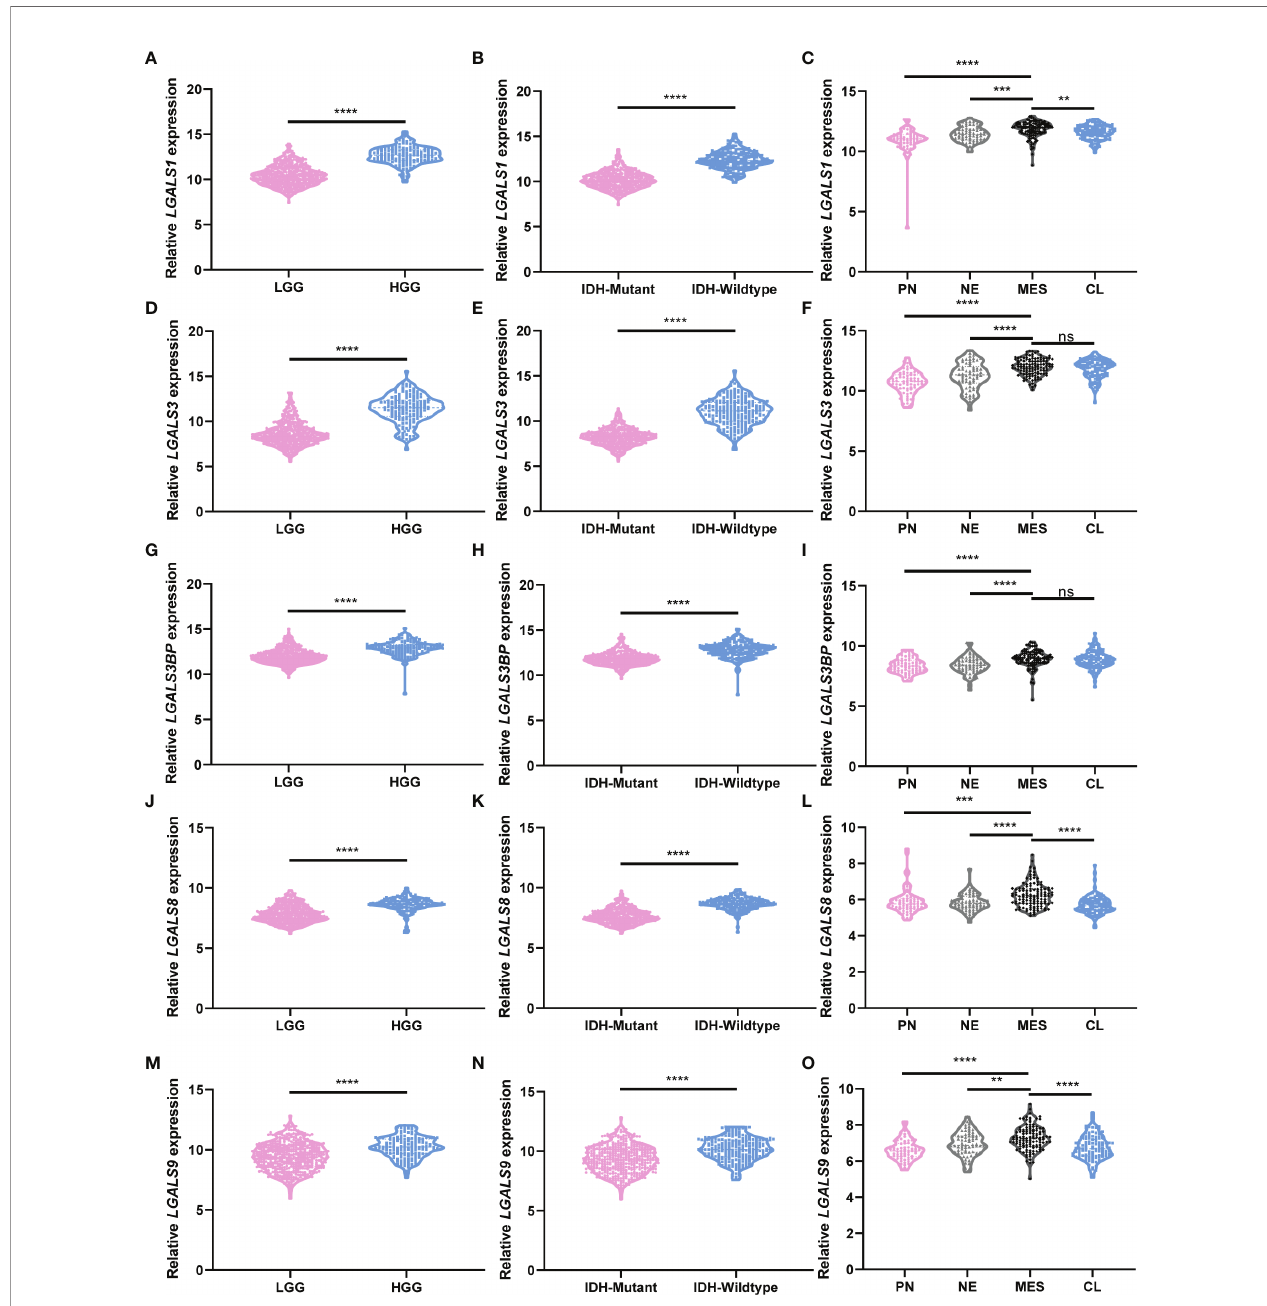
FIGURE 4 | LGALS expression correlates with glioma grades, GBM subtypes, and IDH mutation status in TCGA Glioma dataset. (A) Relative LGALS 1 expression level of LGG and HGG patients in TCGA Glioma dataset. (B) Relative LGALS 1 expression level of IDH-mutant and IDH-wild-type patients in TCGA Glioma dataset. (C) Relative LGALS 1 expression level of different molecular subtype patients in TCGA Glioma dataset. (D – F) Relative LGALS 3 expression level of LGG and HGG patients (D) , IDH-mutant and IDH-wild-type patients (E) , and different molecular subtype patients (F) in TCGA Glioma dataset. (G – I) Relative LGALS 3BP expression level of LGG and HGG patients (G) , IDH-mutant and IDH-wild-type patients (H) , and different molecular subtype patients (I) in TCGA Glioma dataset. (J – L) Relative LGALS 8 expression level of LGG and HGG patients (J) , IDH-mutant and IDH-wild-type patients (K) , and different molecular subtype patients (L) in TCGA Glioma dataset. (M – O) Relative LGALS 9 expression level of LGG and HGG patients (M) , IDH-mutant and IDH-wild-type patients (N) , and different molecular subtype patients (O) in TCGA Glioma dataset. IDH, isocitrate dehydrogenase; GBM, glioblastoma; TCGA, The Cancer Genome Atlas **p<0.01, ***p<0.001, ****p<0.0001, ns, No signi fi